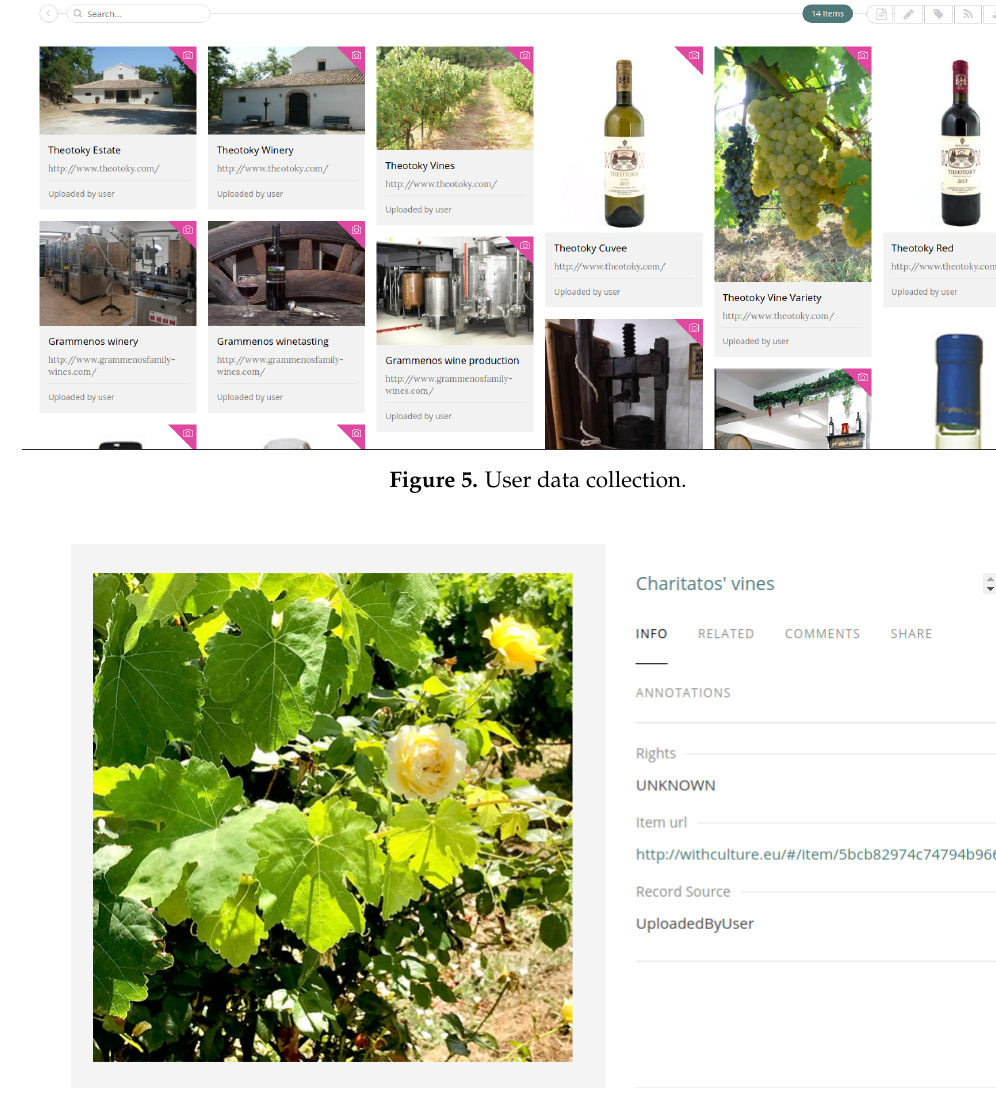
Figure 6. Selected item from the